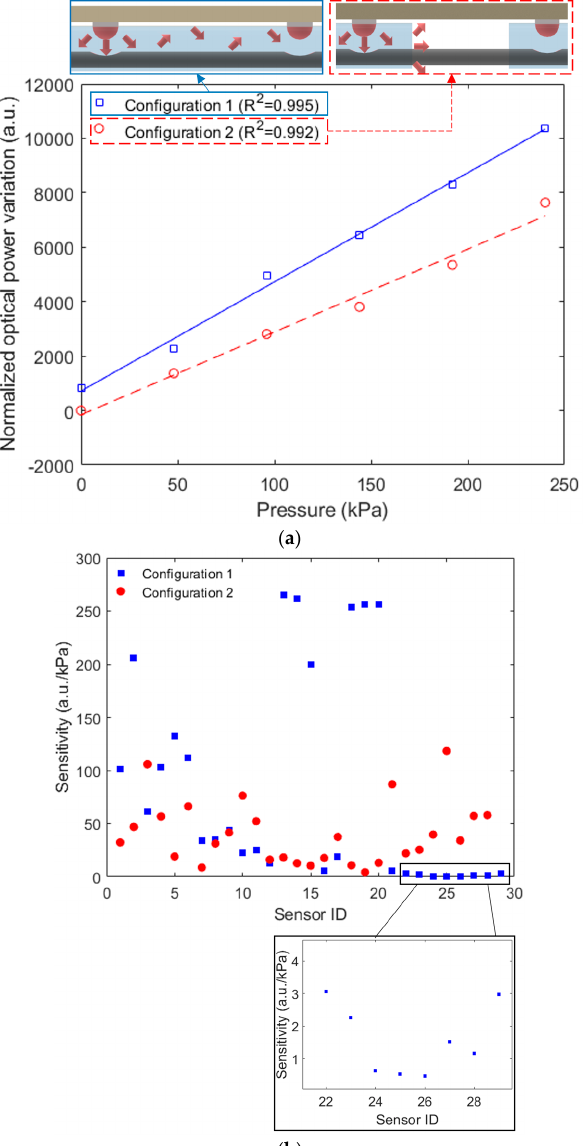
Figure 5. ( a ) Transmitted optical power variation as a function of force for each configuration. Figure inset shows the schematic representation of the light coupling between the adjacent sensors. ( b ) Sensor pressure sensitivities as a function of each sensor ID. Figure inset shows a magnified view of Sensors 22 to 29 in Configuration 1 . An experimental analysis of the cross-talk between adjacent sensors is presented in Figure 6a for Configuration 1 and Figure 6b related to Configuration 2, where the pressure